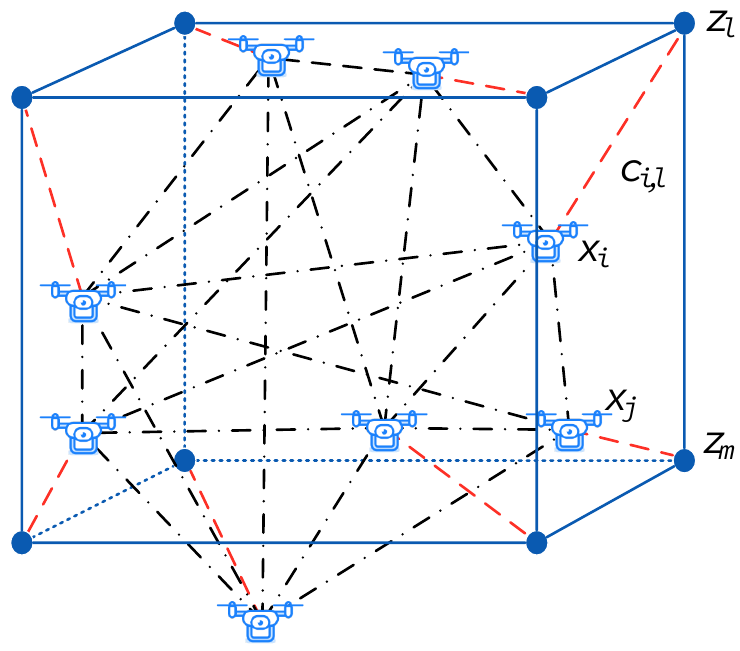
Figure 1. An example of topology mapping for UAV swarm. The coordinate system of target topology is constructed based on the inter-distance derived from the topology shape. Assuming that the coordinates of position l in the target topology are z l = [ a l , b l , c l ] T ∈ R 3 × 1 , l = 1, 2, . . . , N , and Z = [ z T ∈ R N × 3 denotes the coordinate matrix of target topology. The distance between z is denoted